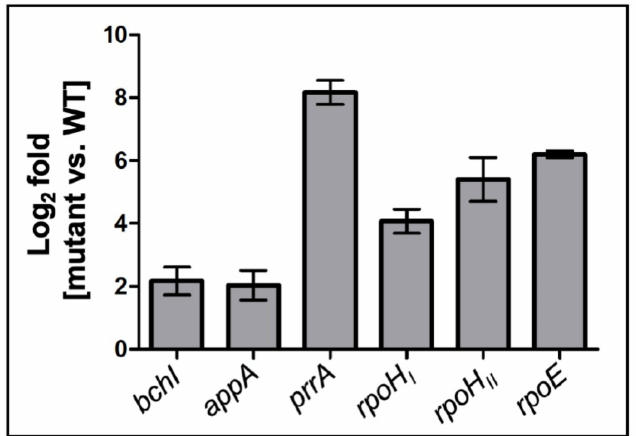
Figure 3. Ratio of expression (log 2 -fold change) of selected genes as determined by real time RT PCR in the ∆ StsR mutant compared to the wild type. An in vitro transcript of sinI RNA, an external spike-in RNA of known sequence and quantity, was used for